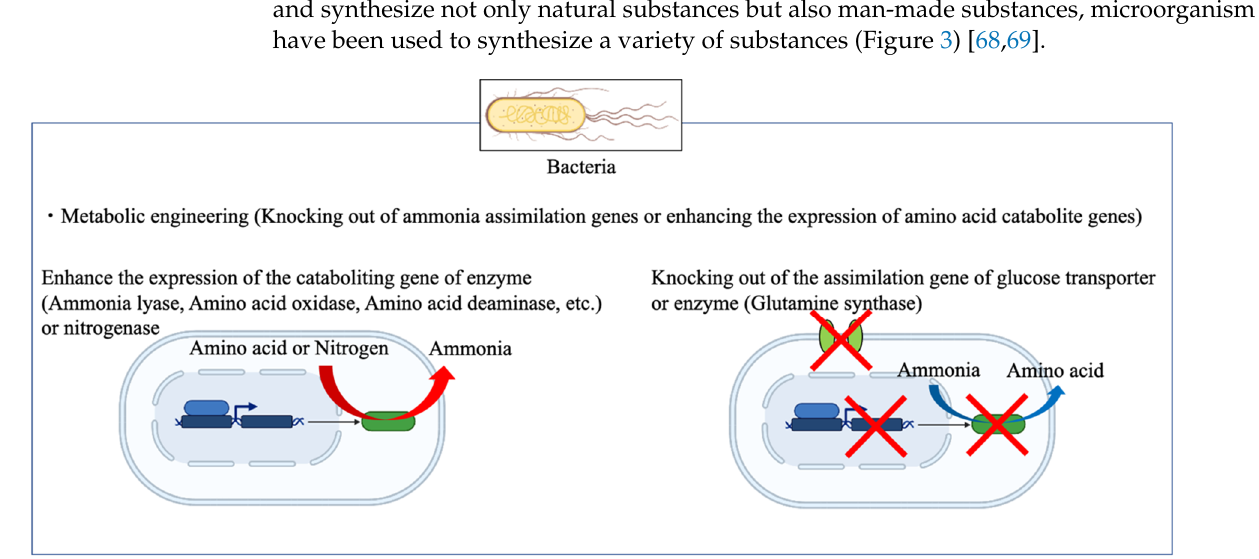
Figure 2. Sustainable ammonia production (created with Biorender.com).